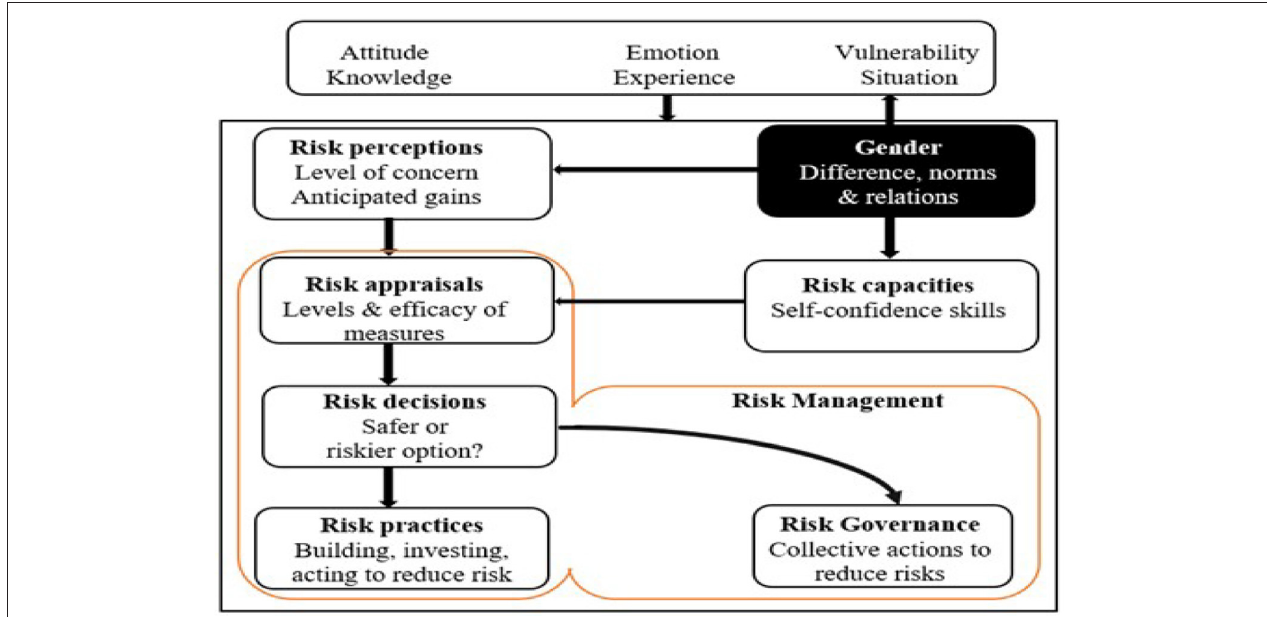
FIGURE 1 | Gender may influence risk perceptions and management directly or through impacts of other factors such as attributes, emotions or vulnerability. Source: Lebel et al. (2015),